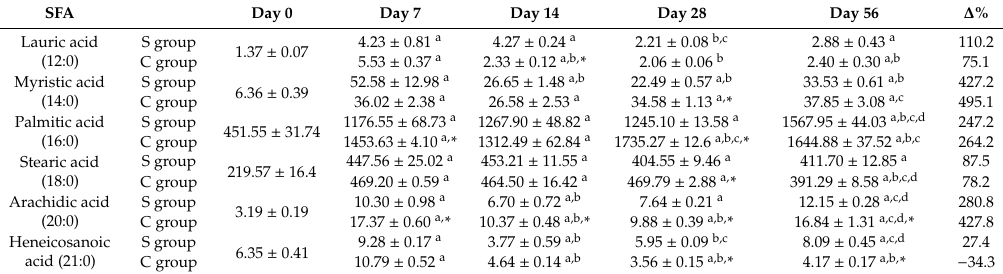
Table 3. Saturated fatty acid (SFA) composition (mg / 100 g of sample) in the livers of mice fed with a diet containing soybean oil (S group) or canola oil (C group) as a lipid source, at 0, 7, 14, 28, or 56 days after starting the diets.